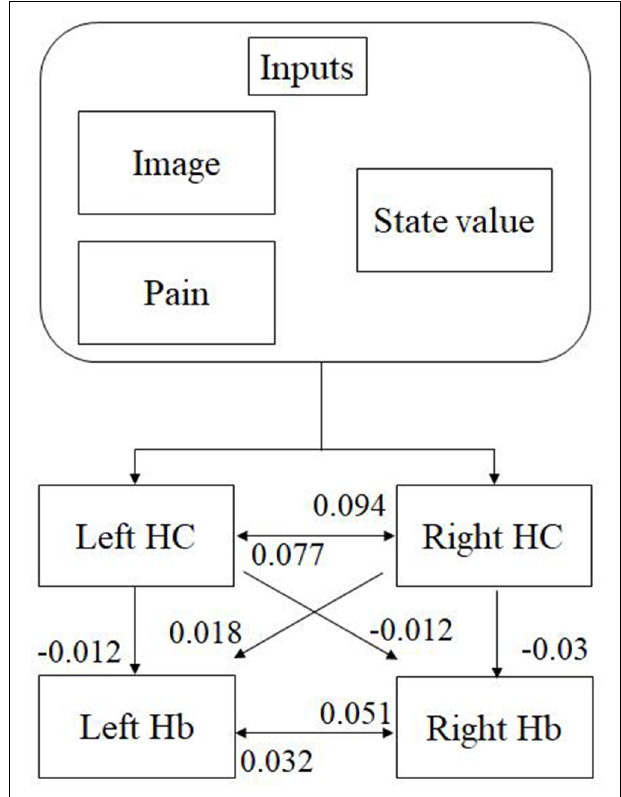
FIGURE 6 | The most suitable model selected among the competitive models. The model has inputs of background images, pain, and state values only to the hippocampus, as well as connections from the hippocampus to habenula. The value shows intrinsic connectivity